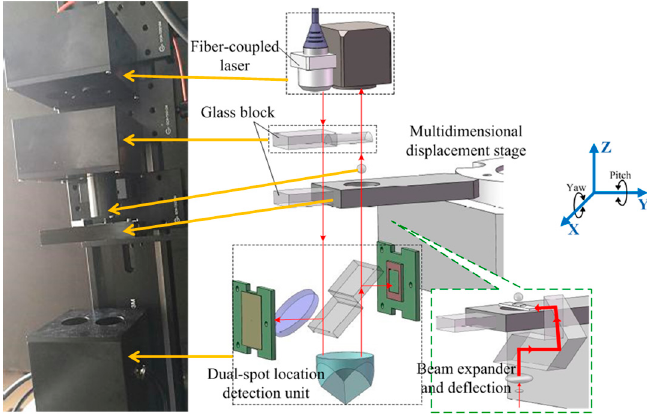
Figure 8. Schematic of the micro-imaging system with a dual-spot position detection unit.